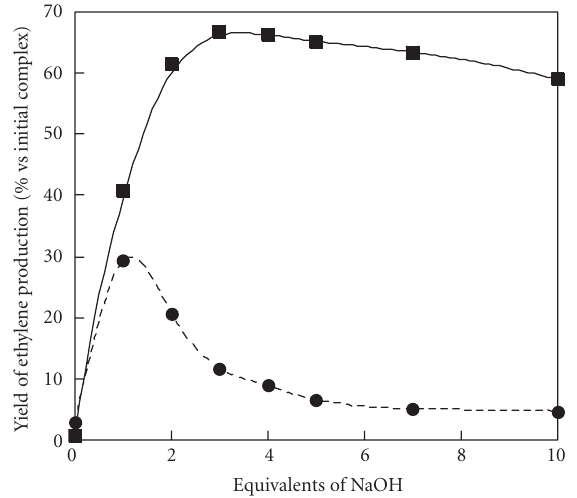
Figure 5: Ethylene production in MeOH by complexes 1 (— (cid:2) —) and 2 (- - • - -) in the presence of 10 equivalents of H 2 O 2 as a func- tion of NaOH. For complex 2 , the conversion was estimated consid- ering only one equivalent of ACC per copper.